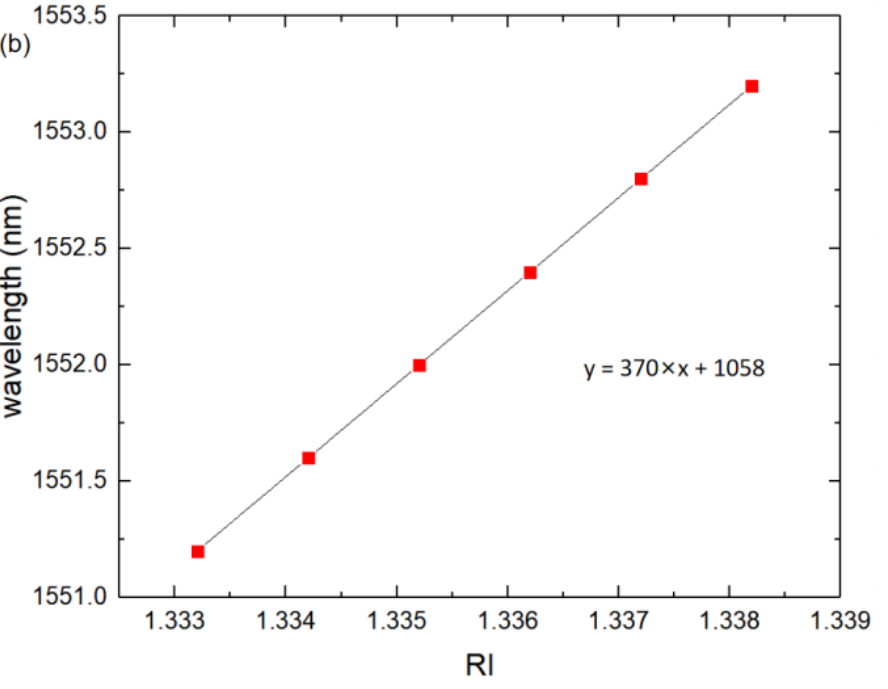
Figure 12. ( a ) Transmission spectra under different environmental refractive indices ( b ) Curve of wavelength changing with environmental refractive index.